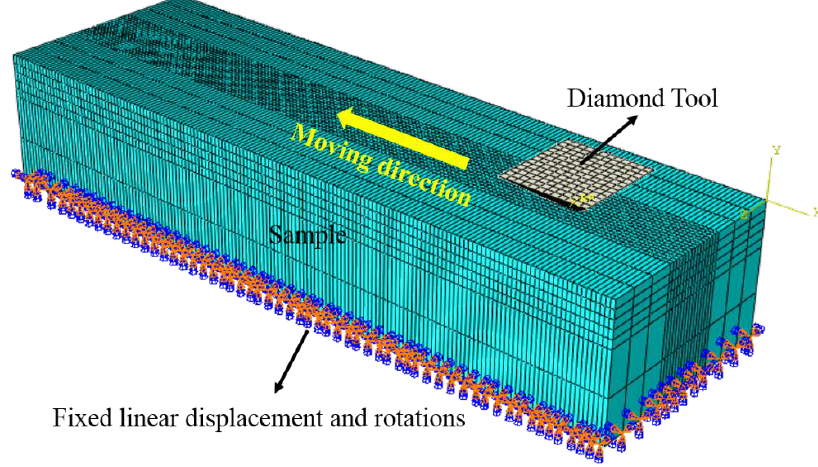
Figure 6. The 3D simulation of single-grit